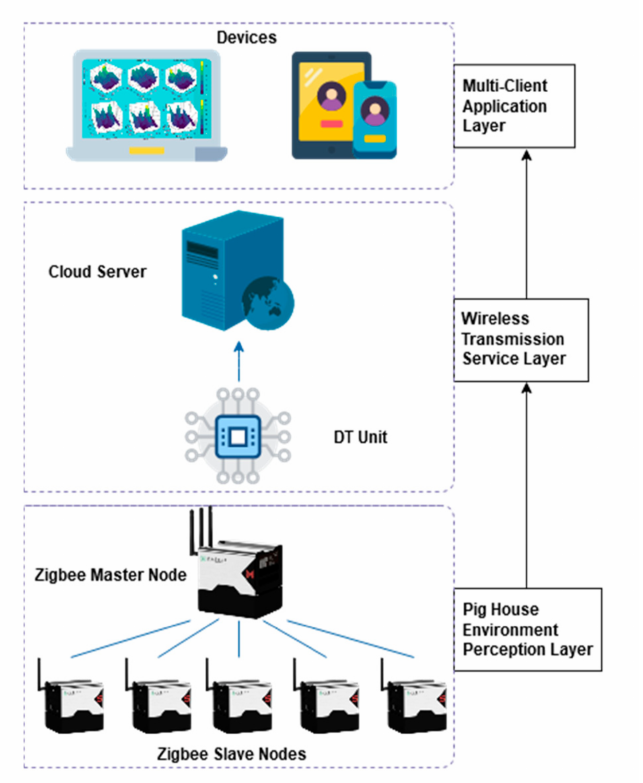
Figure 3. Flowchart of the pig housing wireless sensor network (WSN)